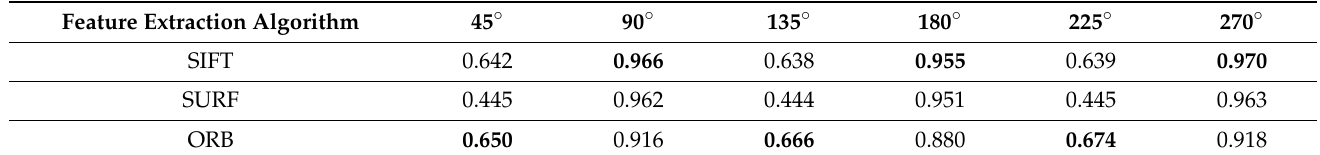
Table 6. Matching rate versus the rotation angle. Best results are marked in bold. Feature Extraction